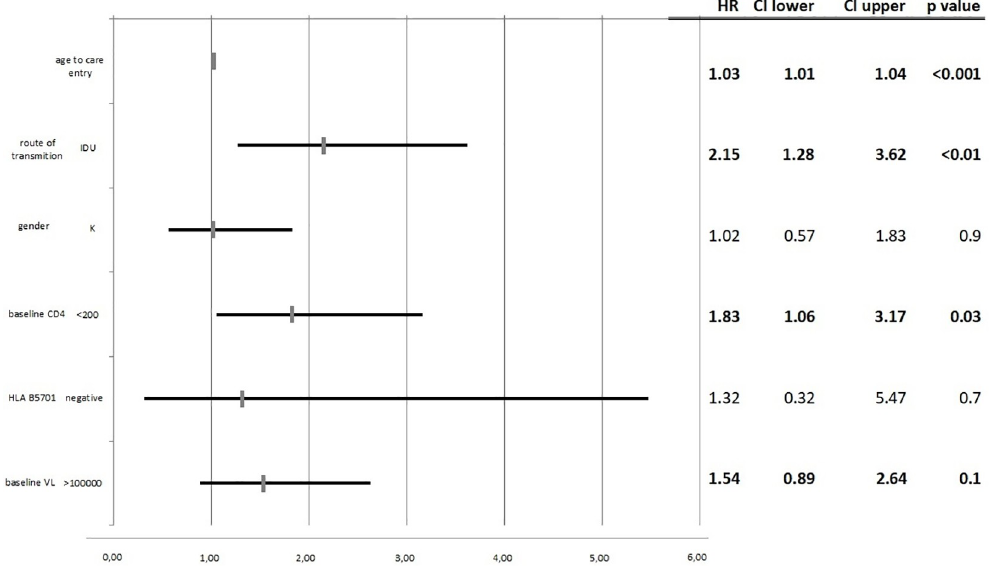
Fig 1. Multivariate logistic regression for the selected survival associated factors for the 20 year timepoint.